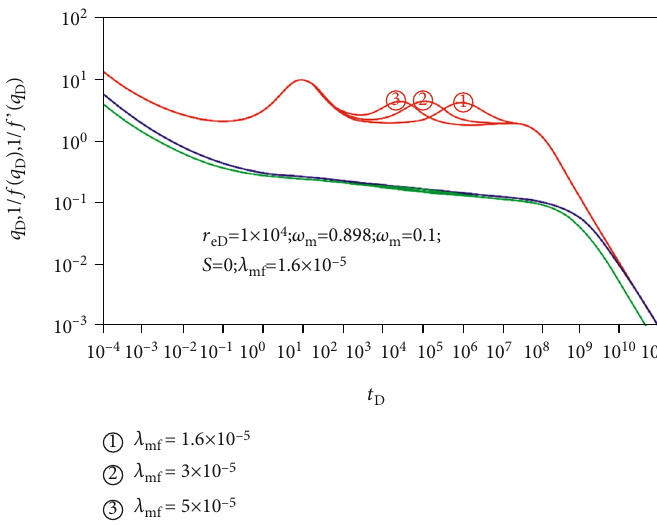
Figure 12: In fl uence of interporosity fl ow of the matrix system to the fracture system, λ